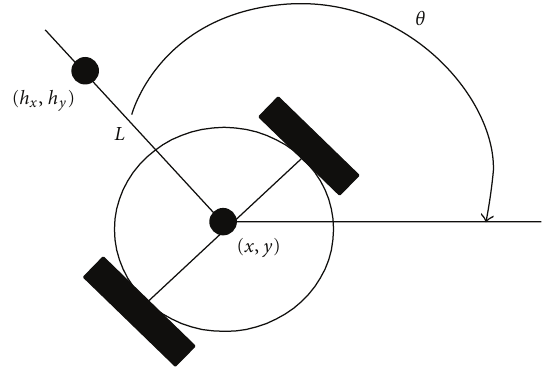
Figure 2: Hand position for P3 mobile